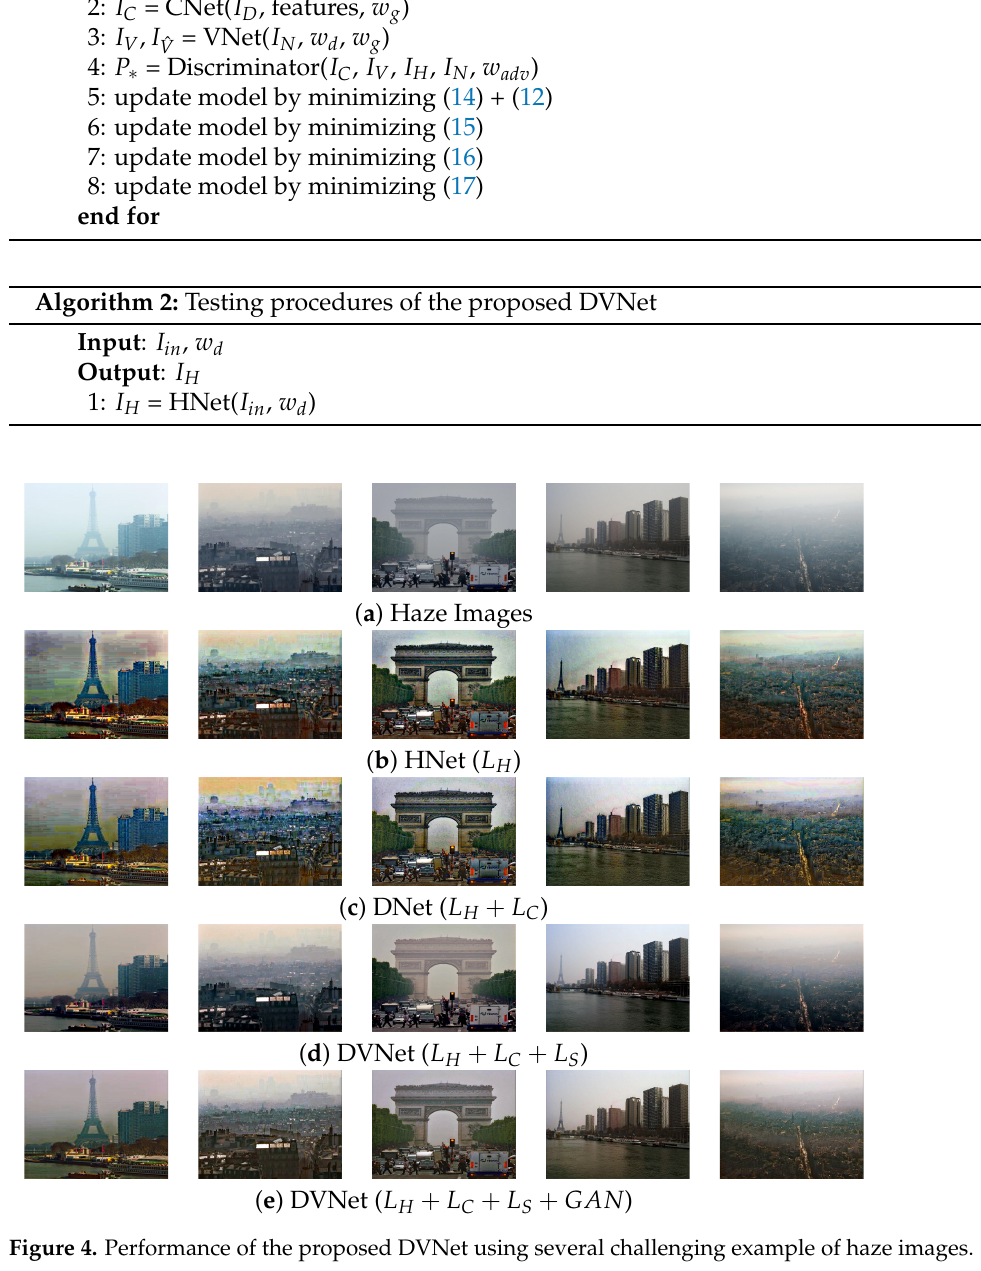
Figure 4. Performance of the proposed DVNet using several challenging example of haze